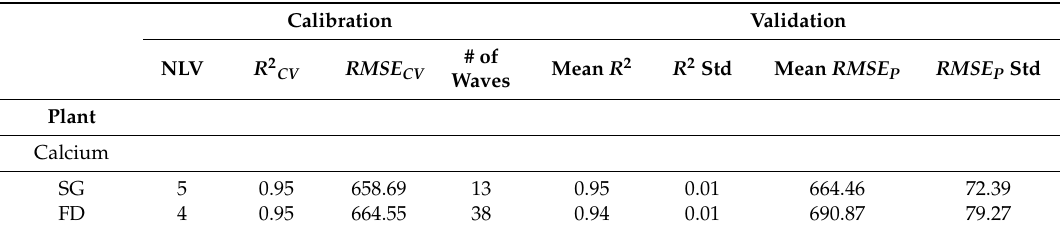
Table 7. Partial least squares regression (PLS) results for the waveband selection model (PLS-Wave) for plant and grain using the combined Untied States and Ethiopia (USET) dataset. SG: Savitsky–Golay; FD: First derivative; NLV: Number of latent variables; std: Standard